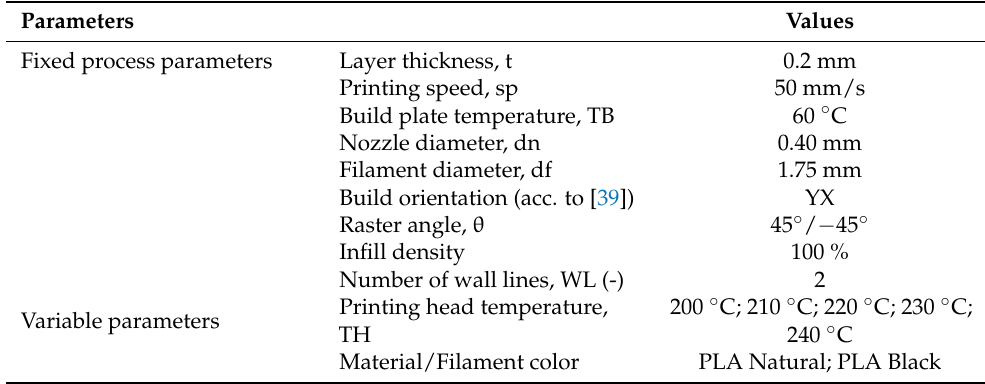
Table 1. 3D-printing